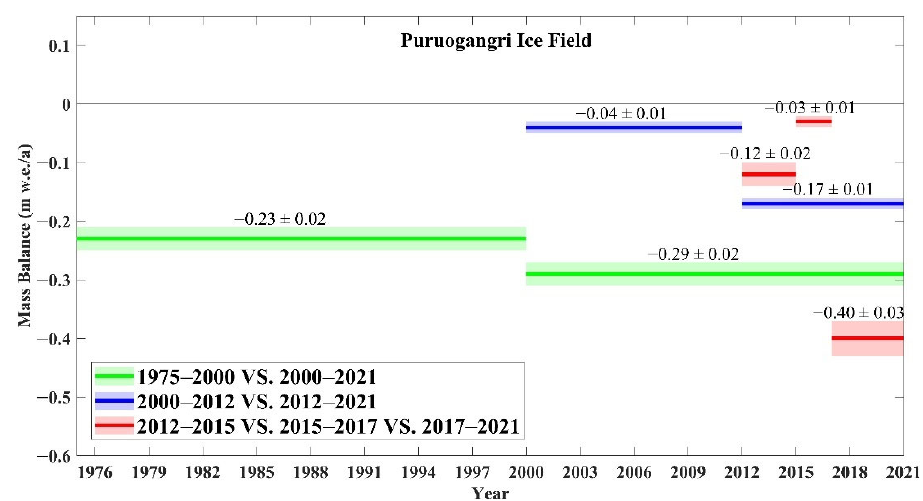
Figure 9. A comparison of the mass balance of the Puruogangri Ice Field during different periods.